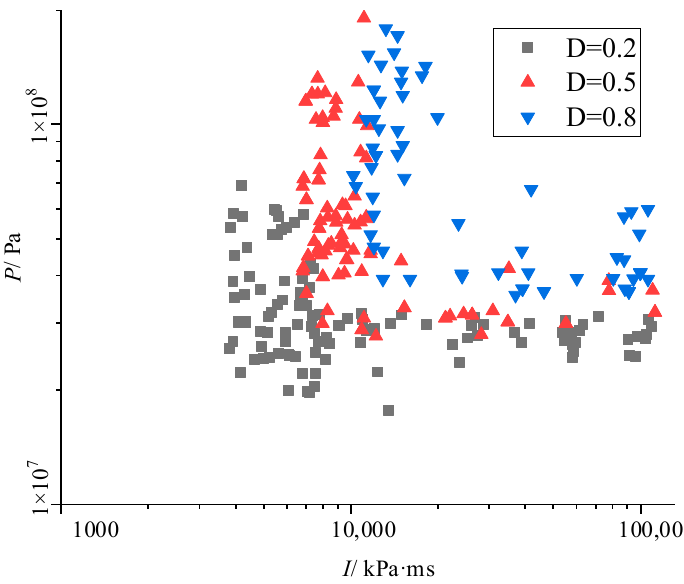
Figure 6. Data points corresponding to different degrees of damage. The data points were filtered, and the nonlinear curve was fitted using Origin software. After multiple parameter adjustments and fittings, the P - I curve with the best fitting degree with the filtered data points was obtained, as shown in Figure 7. From the lower left to the upper right, the damage degree of the roadway wall is shown to be increasing. The P - I diagram is divided into four parts by three damage curves, which correspond to the four damage grades of the roadway wall. When the P - I value falls at the lower left of the damage curve of D = 0.2, the damage degree of the roadway wall is small due to the small explosion load intensity. When the P - I value falls within the range of D = 0.2 and D = 0.8, the roadway wall is damaged to different degrees. When the P - I value falls above the right of D = 0.8, the roadway wall deformation caused by the explosion load will exceed the maximum value that the roadway wall can bear, and the roadway wall will collapse.